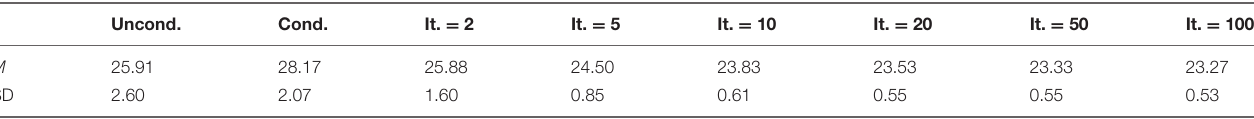
TABLE 8 | Mean, SD, and correlation with Study 2 decisions for payoffs in Study 3. Uncond.